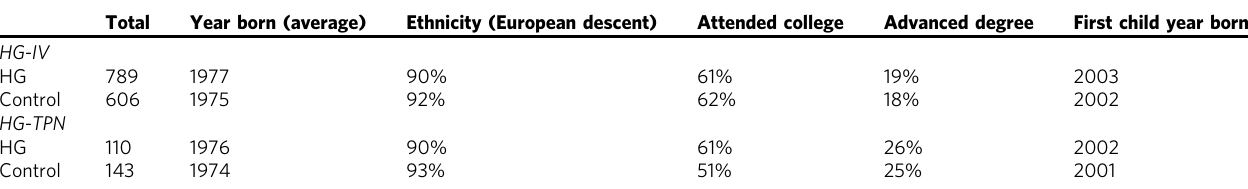
Table 5 Demographic characteristics of the replication cohorts HG-IV consisting of HG patients treated with intravenous (IV) fl uids and controls with untreated NVP, and HG-TPN consisting of HG patients treated with total parenteral nutrition (TPN) and controls with no